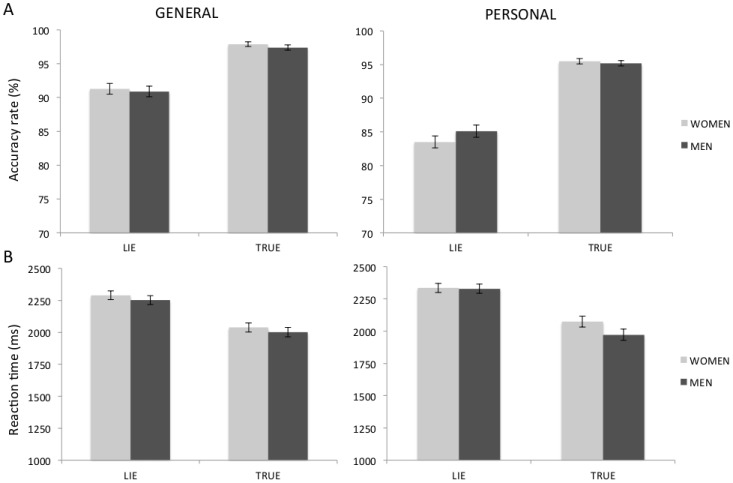
Behavioral results. Mean accuracy rates (A) and reaction times (B) of men and women for deceptive and truthful responses.Error bars represent standard error of the mean. No between-gender effect reached significance.